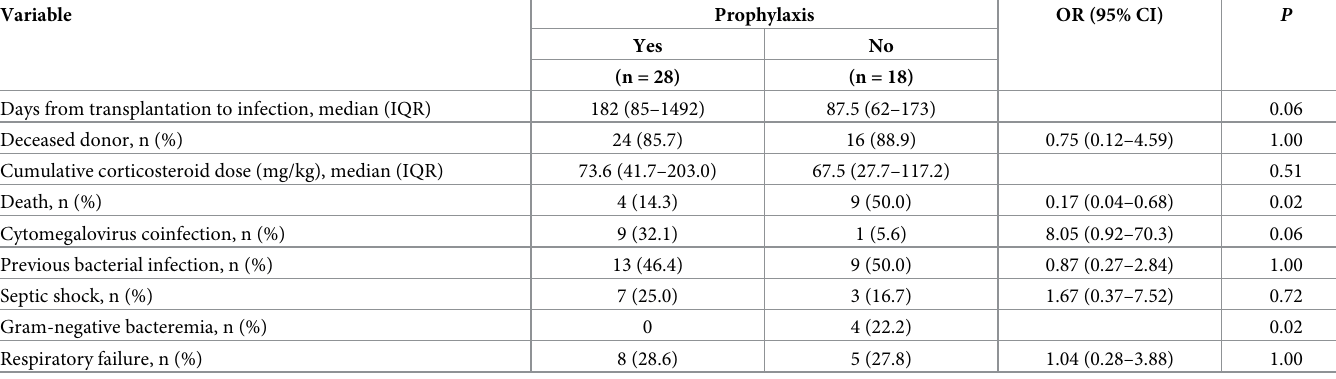
Table 2. Comparison and univariate analysis of the cases receiving and not receiving prophylaxis against S . stercoralis infection, by clinical variables.